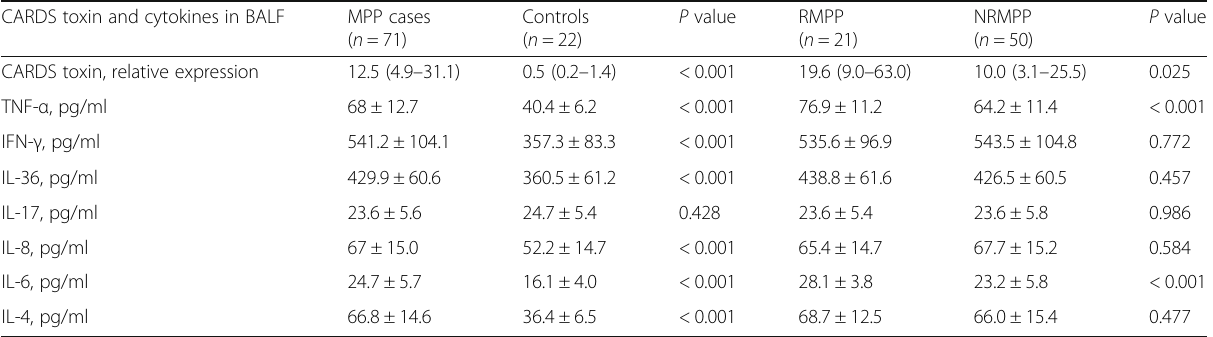
Table 2 Comparison of CARDS toxin and cytokines in BALF from control and MPP (including RMPP and NRMPP) children CARDS toxin and cytokines in BALF MPP cases